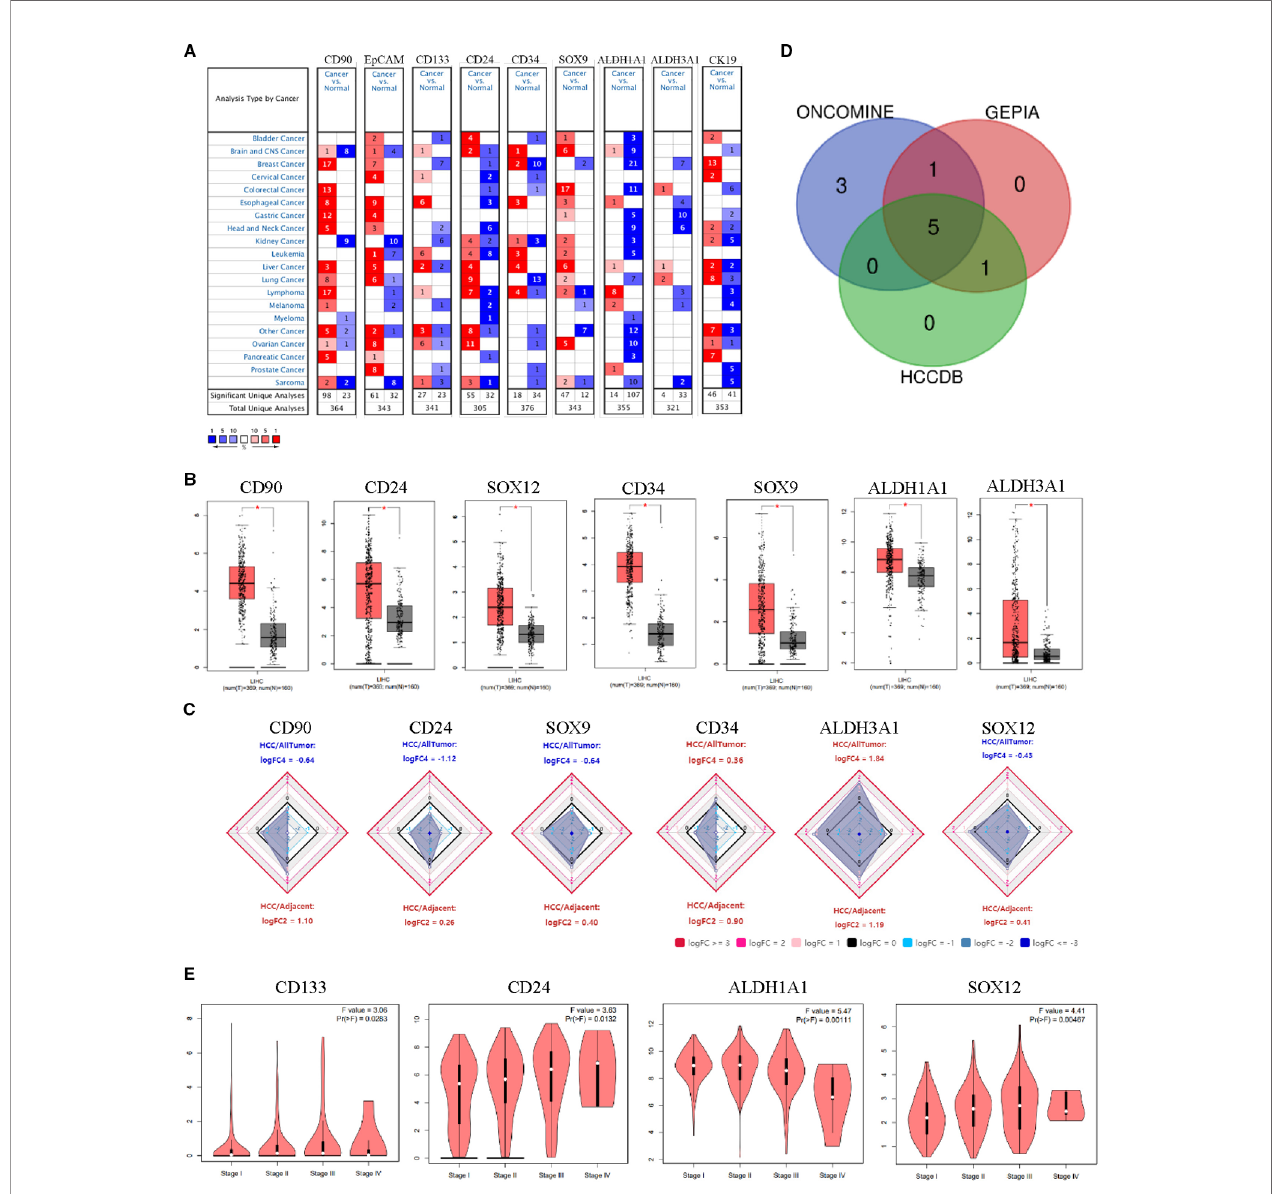
FIGURE 1 | HCSC markers expression levels in HCC. (A) Increased HCSC markers in data sets of HCC compared with normal tissues in Oncomine database. Cell color is determined by the best gene rank percentile for the analyses within the cell. (B) Increased HCSC markers in data sets of HCC compared with normal tissues in GEPIA. Asterisk: P < 0.01. (C) Increased HCSC markers in data sets of HCC compared with normal tissues in HCCDB. (D) Wayne diagrams of the three database results. (E) HCSC markers expression levels at tumor major stages in HCC in